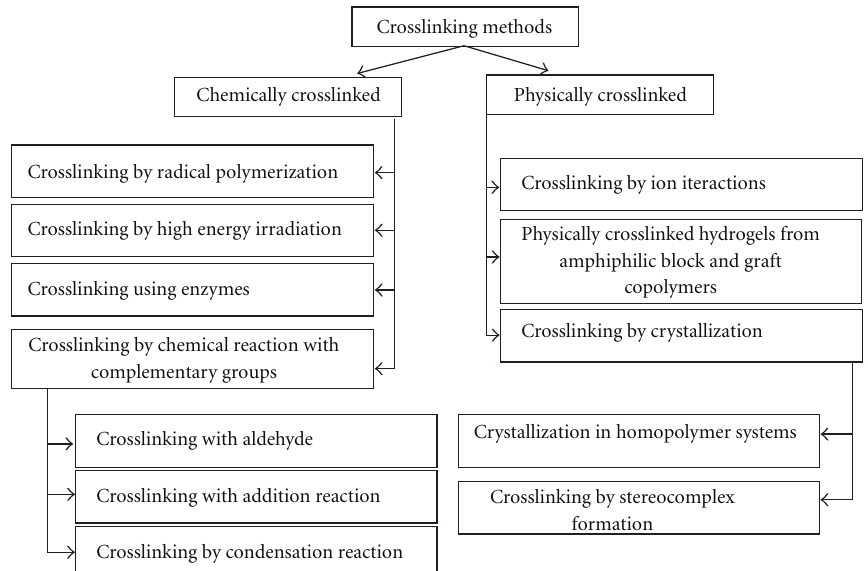
Figure 4: Novel crosslinking methods used in hydrogels